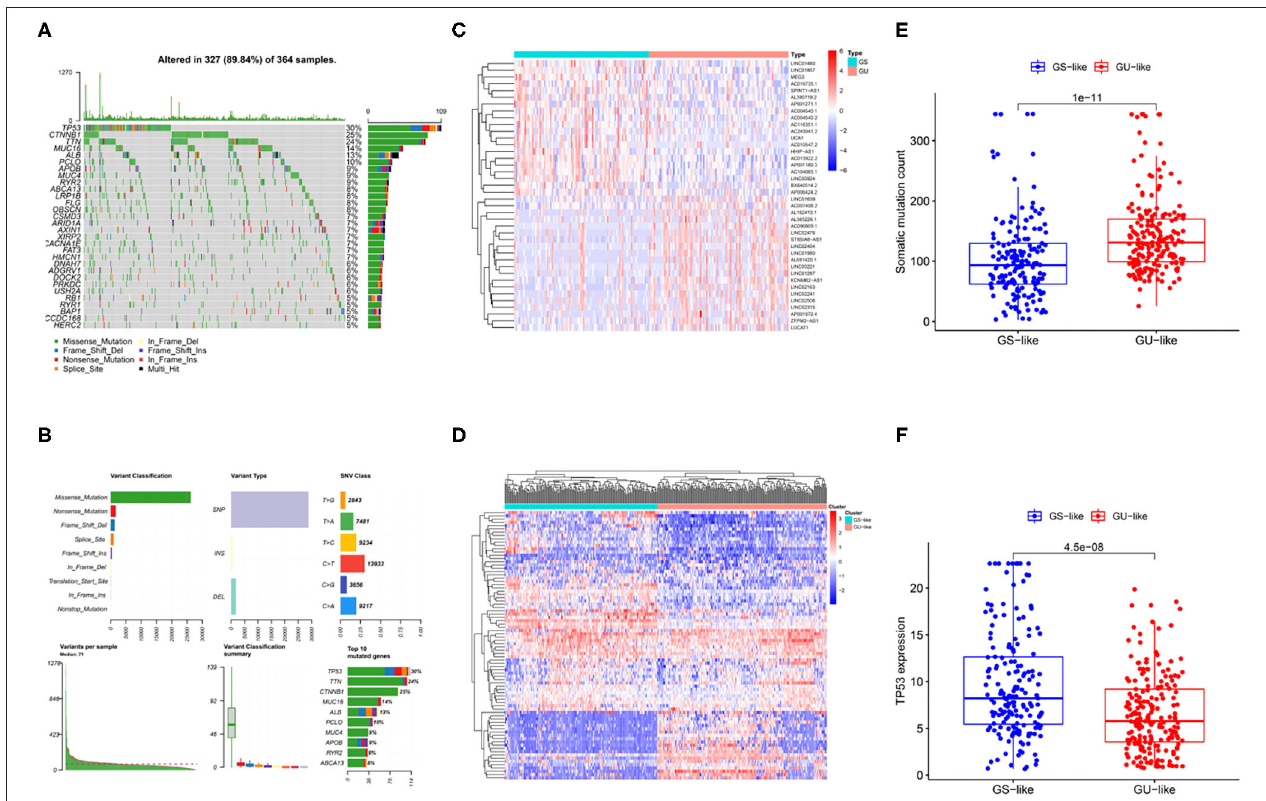
FIGURE 2 | Identification of genomic instability-related lncRNAs in patients with HCC. (A) Waterfall summarized mutational data from patients with HCC. (B) Mutational frequencies in the top 10 genes in the training and testing cohorts. (C) Differentially expressed lncRNAs between GS group and GU group. (D) Hierarchical cluster analyses of TCGA patients with liver cancer based on the expression pattern of 82 genomic instability-related lncRNAs. (E) Boxplots of somatic mutations in the GU-like and GS-like groups. (F) Boxplots of TP53 expression level in the GU-like and GS-like